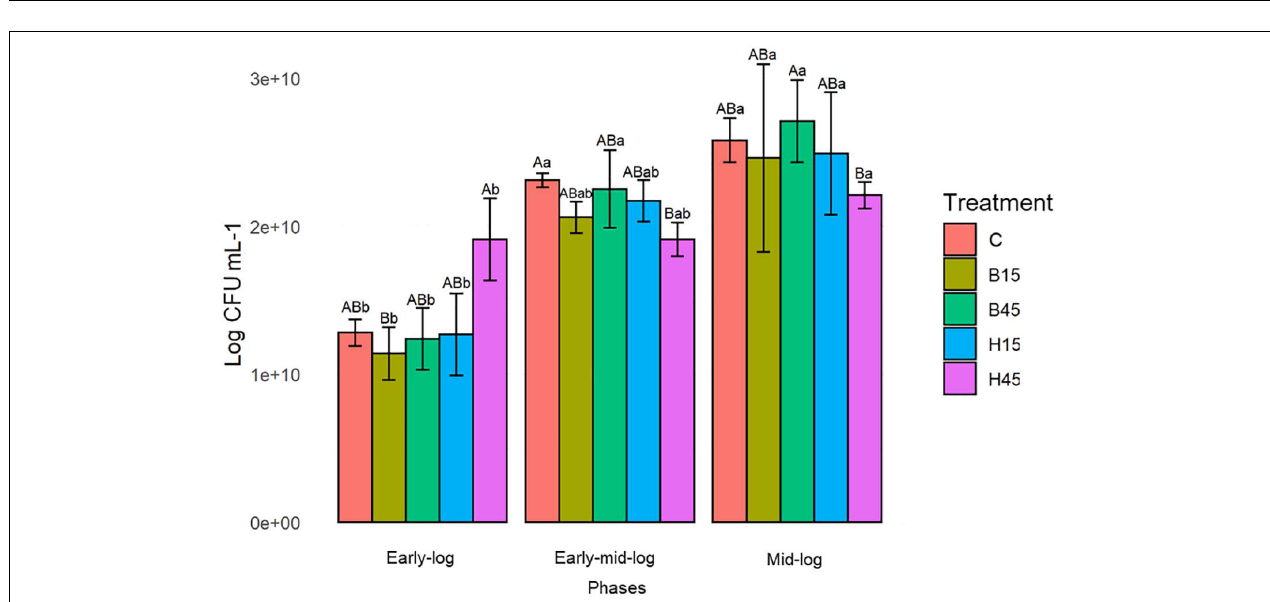
FIGURE 2 | Growth curves of Pseudomonas sp. CMA 6.9 in control treatments (C) and with the herbicides Boral R (cid:13) (B15 and B45) and Heat R (cid:13) (H15 and H45), determined by OD at 600 nm. Data were obtained in triplicate for each treatment and statistically analyzed using a randomized complete block design using the Duncan test ( p < 0.05). Error bars represent standard errors of the means.